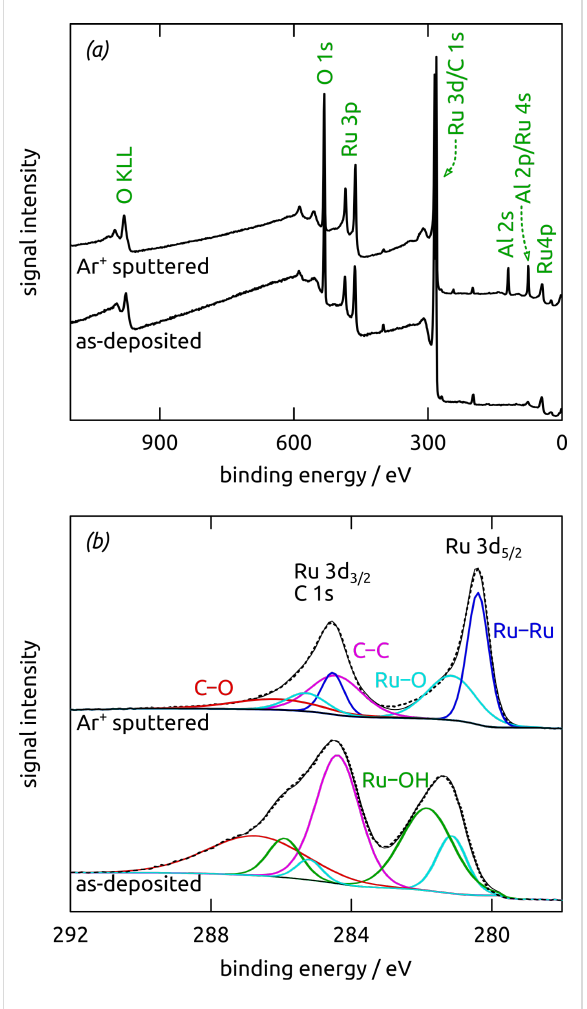
Figure 8: X-ray photoelectron spectra of a nanostructured Ru/C sam- ple recorded as deposited and after Ar + sputtering. All spectra are shifted to a C 1s binding energy position of 284.4 eV. (a) Survey spec- tra showing the expected elements. (b) Ru 3d region, which is super- imposed with the C 1s region, displays the Ru 3d 5/2 and Ru 3d 3/2 peaks. The experimental data are provided as dashed lines, the fit as solid black lines, and the individual deconvoluted peaks are color- coded.